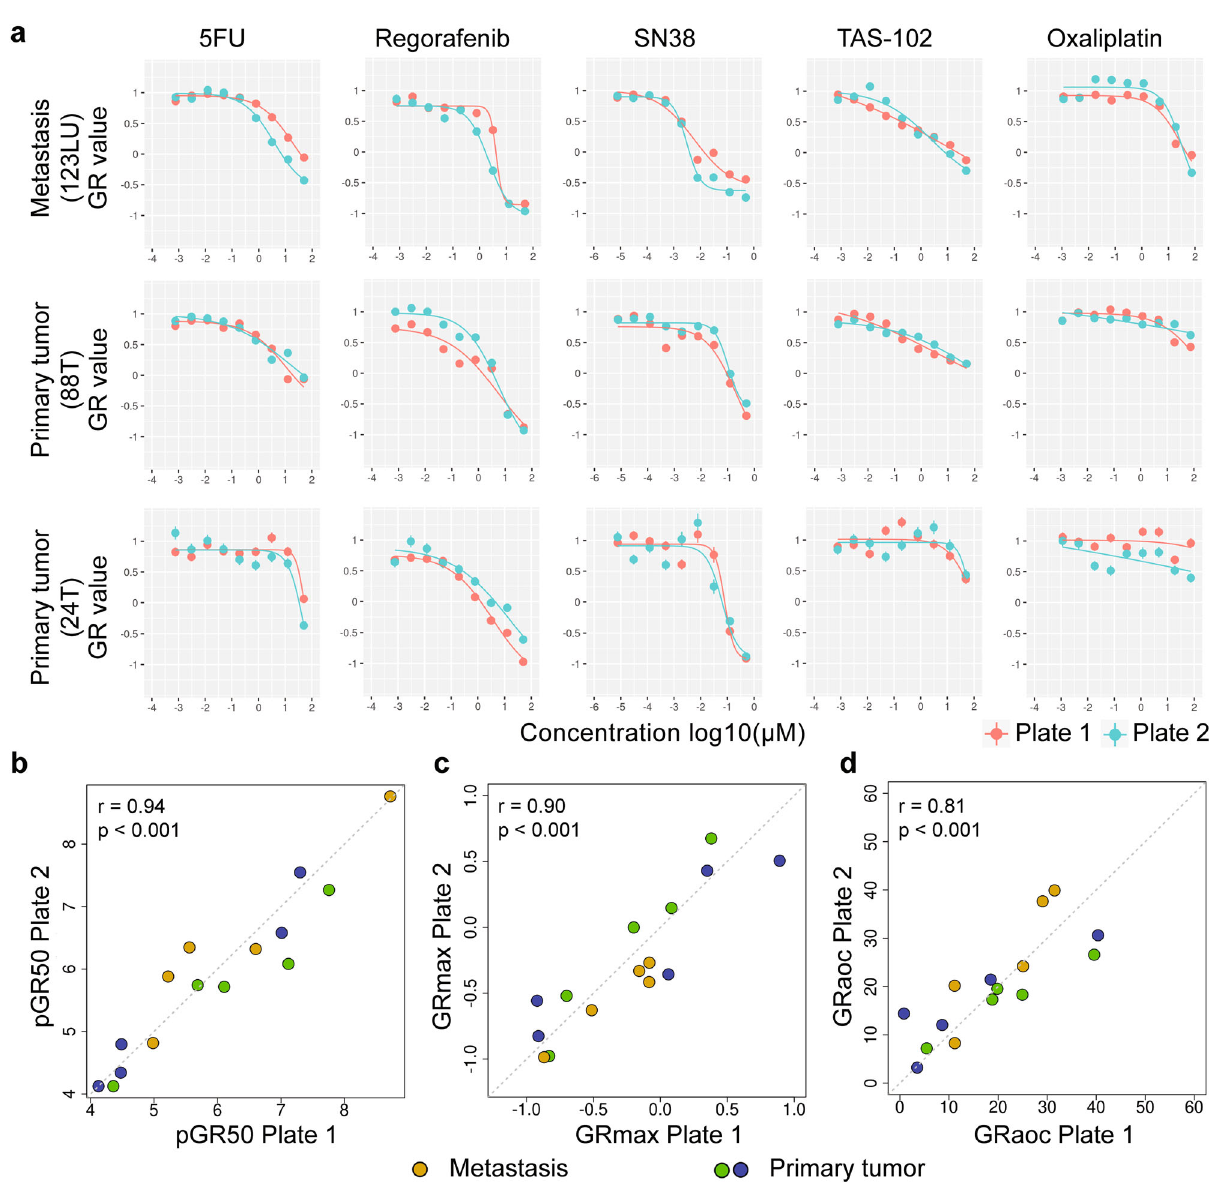
Fig. 9 Reproducibility of imaging-based drug sensitivity testing of tumoroids for clinically relevant agents including 5- fl uorouracil (5-FU), oxaliplatin, SN-38, regorafenib and TAS-102. a , Tumoroids from three patients were assayed in two independent runs consisting of duplicate drug titrations (corresponding 200 – 400 organoids) for 5-FU, oxaliplatin, SN-38, regorafenib and TAS-102. Tumoroid sizes were calculated across duplicate wells and plotted as mean ± s.e.m. Four-parameter logistic regression was used to fi t drug dose-response curves. b – d Between run correlations for ( b ) pGR50 ( c ) GR max and ( d ) GR aoc estimates. Statistical signi fi cance ( b – d ) was attributed to values of p < 0.05 as determined by the t test and Pearson ’ s correlation coef fi cient (r). T, tumor; LU, lung